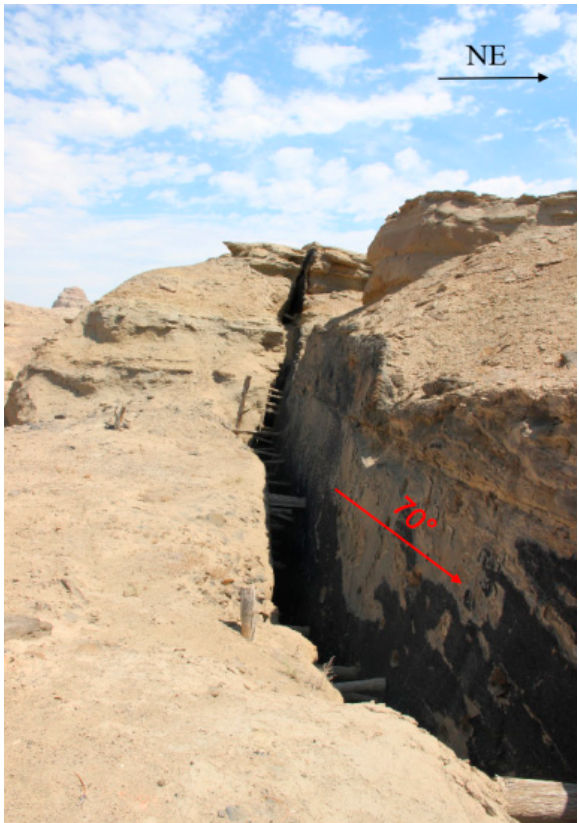
Figure 4. Normal fault characteristics of Wuerhe asphalt vein, showing the sandstone on both sides of the fault with a width of 0.5–1.5 m, forming a black asphalt vein due to bitumen impregnation.